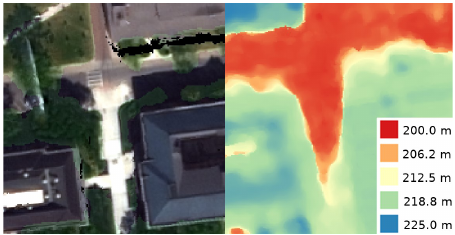
Figure 3. Left: orthophoto generated from satellite images. Right: DSM generated from satellite images. The resolution of side-view and over-view sources are significantly different, as the GSD (ground sampling distance) of the satellite point clouds is about 0.5 m, and pixel GSD of side-view image is less than 0.01 m. The resolution differences lead to different uncertainty of the resulting point accuracy. Therefore, it is expected that the resulting meshes can be heterogeneous in terms of their level of details.